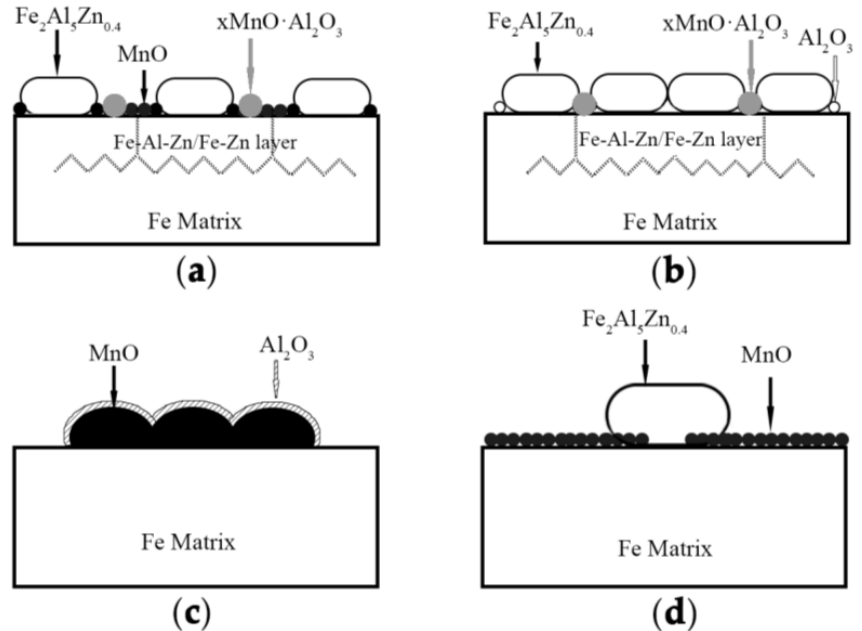
Figure 10. Schematic illustration of the reactive wetting influenced by alloy content and dew point during hot-dip galvanizing of medium Mn lightweight steel. ( a ) 3Mn +10 °C, ( b ) 3Mn − 30 °C, ( c ) 10Mn +10 °C, ( d ) 10Mn − 30 °C.